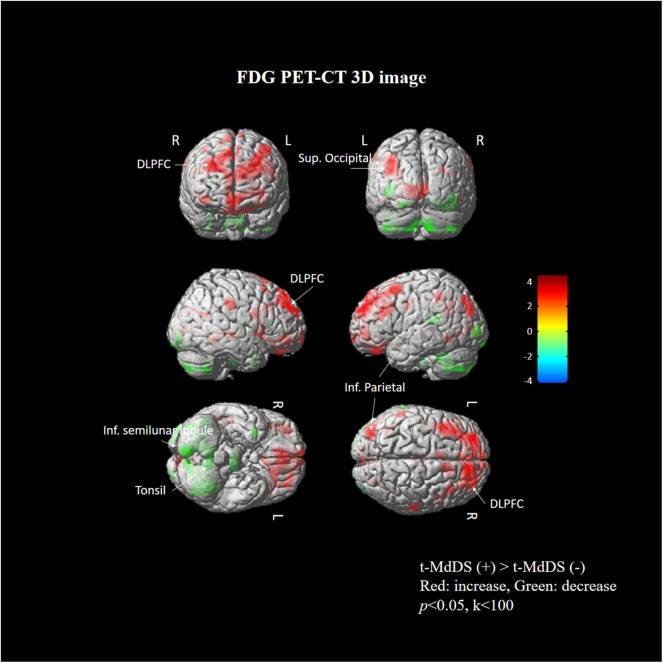
Areas of relative hyper- and hypometabolism in participants with t-MdDS compared with those without. Image is presented at z > 2.57 for better visualization; extent voxels: 0.